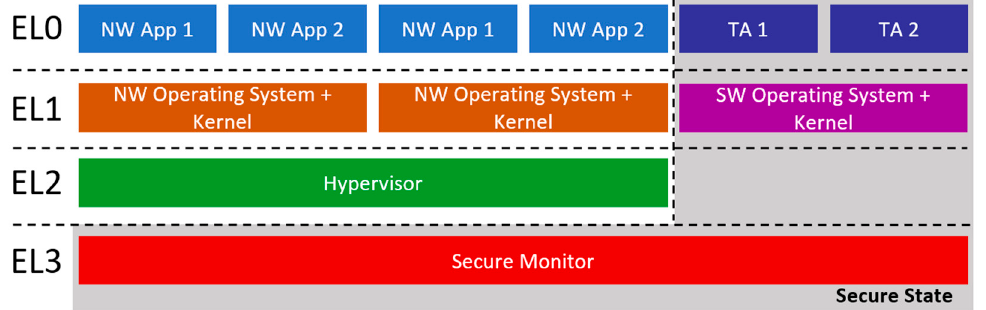
Figure 1. ARMv8 exception level architecture.